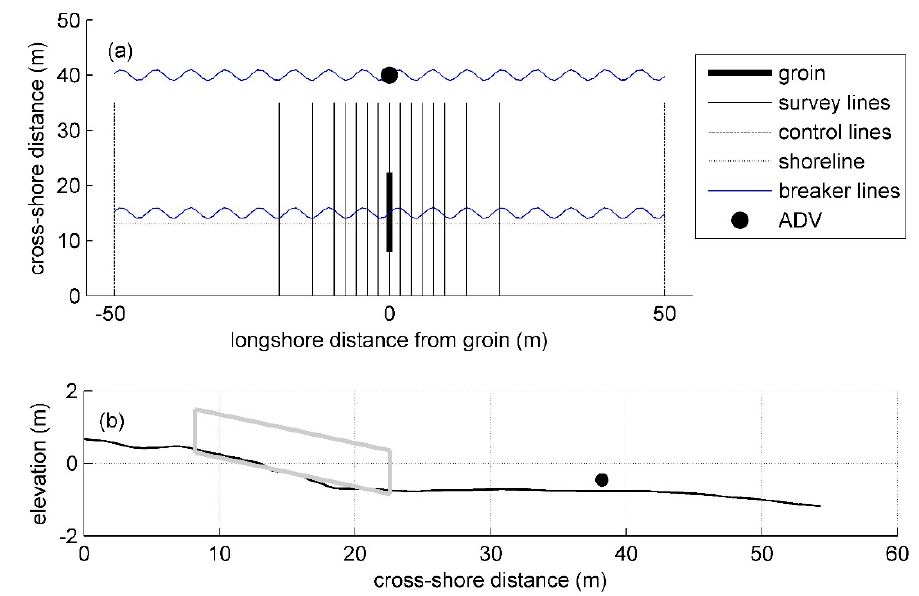
Figure 5. ( a ) Plan view of the survey lines and the structure location, showing the breaker lines and ADV location. ( b ) Beach profile of the middle transect showing the ADV location with respect to the structure.